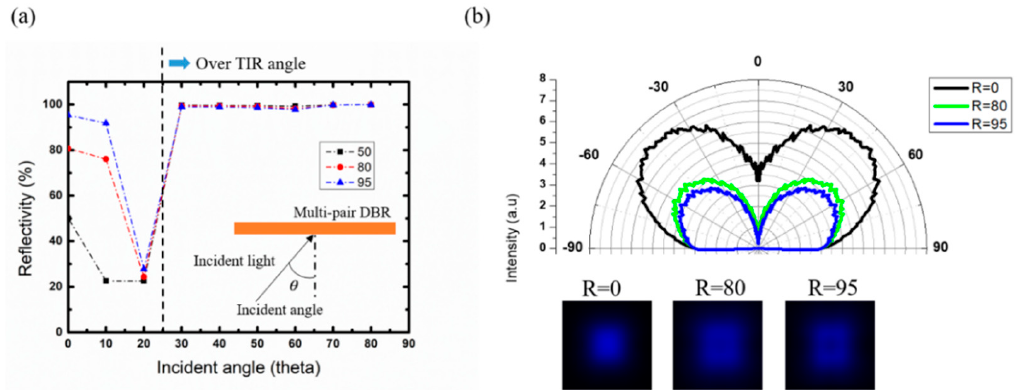
Figure 3. Single chip with distributed Bragg reflector (DBR). ( a ) Reflectance. ( b ) Angular distribution and singular-image pattern.